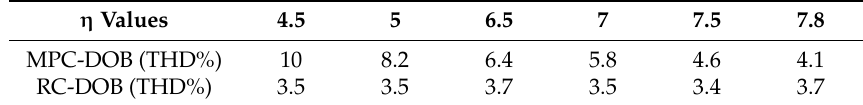
Table 6. THD values for di ff erent η under the nonlinear load ( R nl = 200 Ω , L nl = 2.6 mH, C nl = 2200 µ